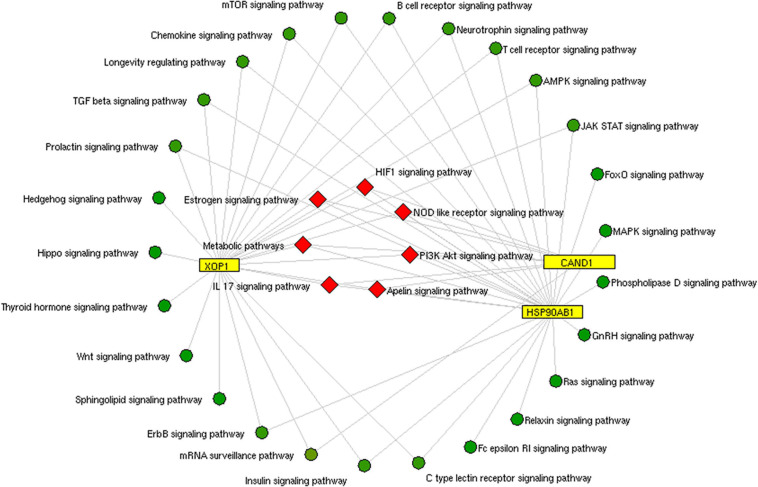
Pathway enrichment of hubs: The common pathway (red rhombus) shared by three protein hubs (yellow rectangle) extracted from the metalloprotein network.